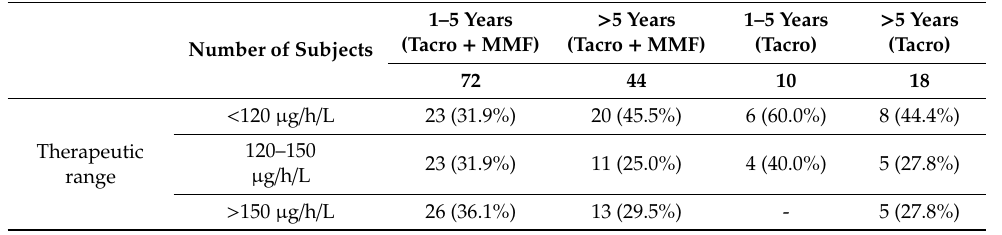
Table 3. Comparative table of the Tacro AUC exposure values’ compliance within therapeutic ranges.